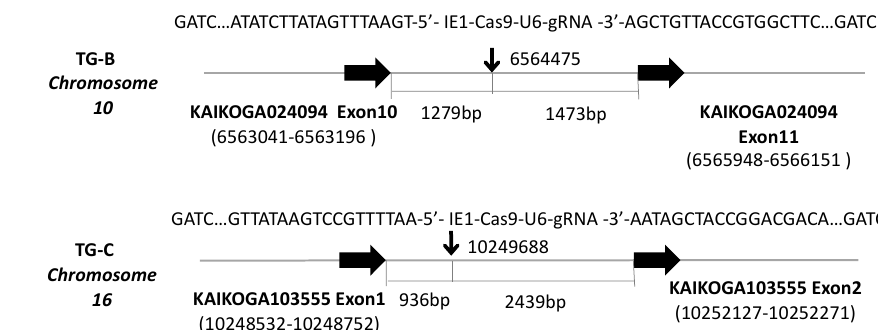
Figure 1. Construction of transgenic silkworm lines that express Cas9 and sgRNAs targeting BmNPV lef8 and lef9 . ( A ) Schematic representation of the location of targeted sequences within the BmNPV genome. The rectangle represents the BmNPV genome, and the two large black arrows represent the lef8 and lef9 genes. The drawing is not to scale. The target sequences are green, and the PAM sequences are red. ( B ) Schematics of the plasmid pBac [ IE1 -EGFP- IE1 -Cas9-U6- lef8 + lef9 sgRNAs] for expression of Cas9 and sgRNAs. ( C – E ) Locations of genomic insertions of the pBac [IE1-EGFP- IE1-Cas9-U6- lef8 + lef9 sgRNAs] construct in TG-A ( C ), TG-B ( D ), and TG-C ( E ) transgenic B. mori lines. The vertical arrows indicate the insertion sites in the chromosome. The horizontal black arrows represent contiguous genes of the insertion sites. The interspace distance between the insertion sites of the construct and its contiguous genes is indicated in base pairs.